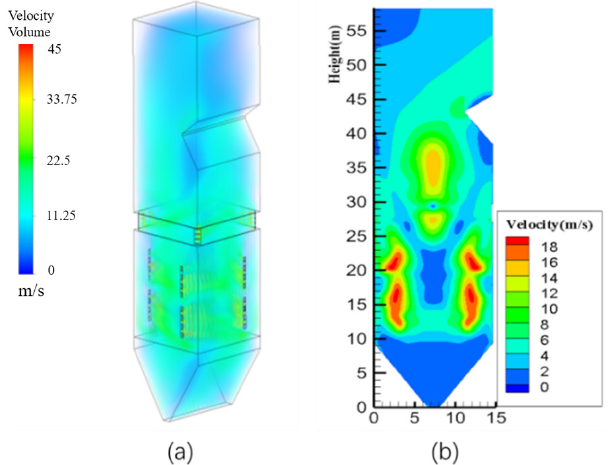
Figure 3. Distribution contours diagram of longitudinal airflow velocity in furnace. ( a ) Velocity distribution. ( b ) Gas phase flow rate in the central longitudinal section.